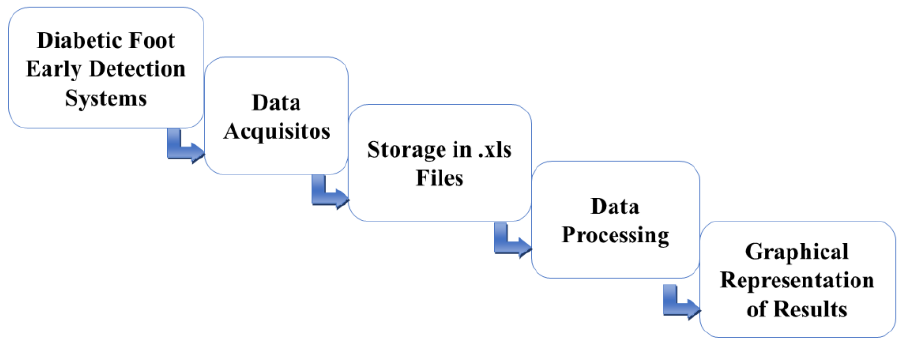
Figure 5. Diagram of the hub of information on diabetic foot. This shows the synchronous process that the systems follow to achieve the results. First, the data acquisition through USB, which operates at a maximum speed of 480 Mbps to each of the systems, then saves the information in .xls format to use it later on. The device reads through the file using Python language; then, the system finds the graphical results [26].